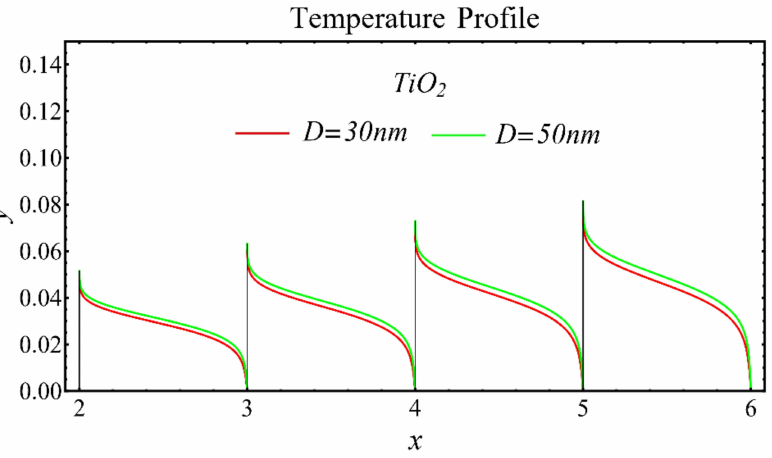
Figure 18. Temperature profile of TiO 2 -EG nanofluid under influence of nanoparticle